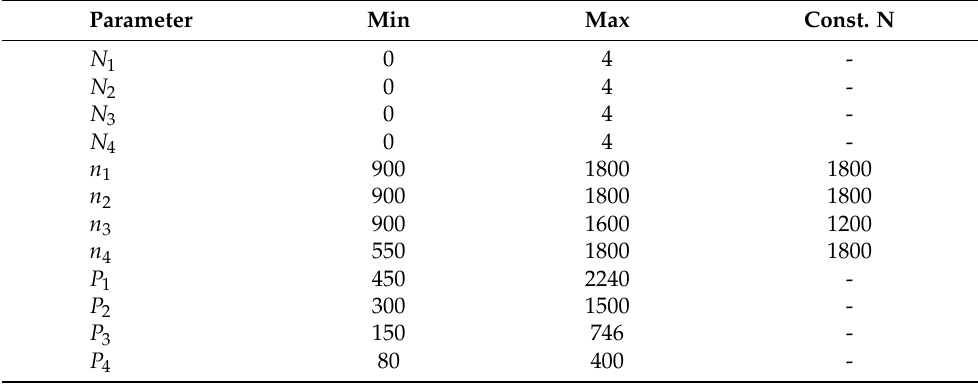
Table 3. Boundary values of the optimisation